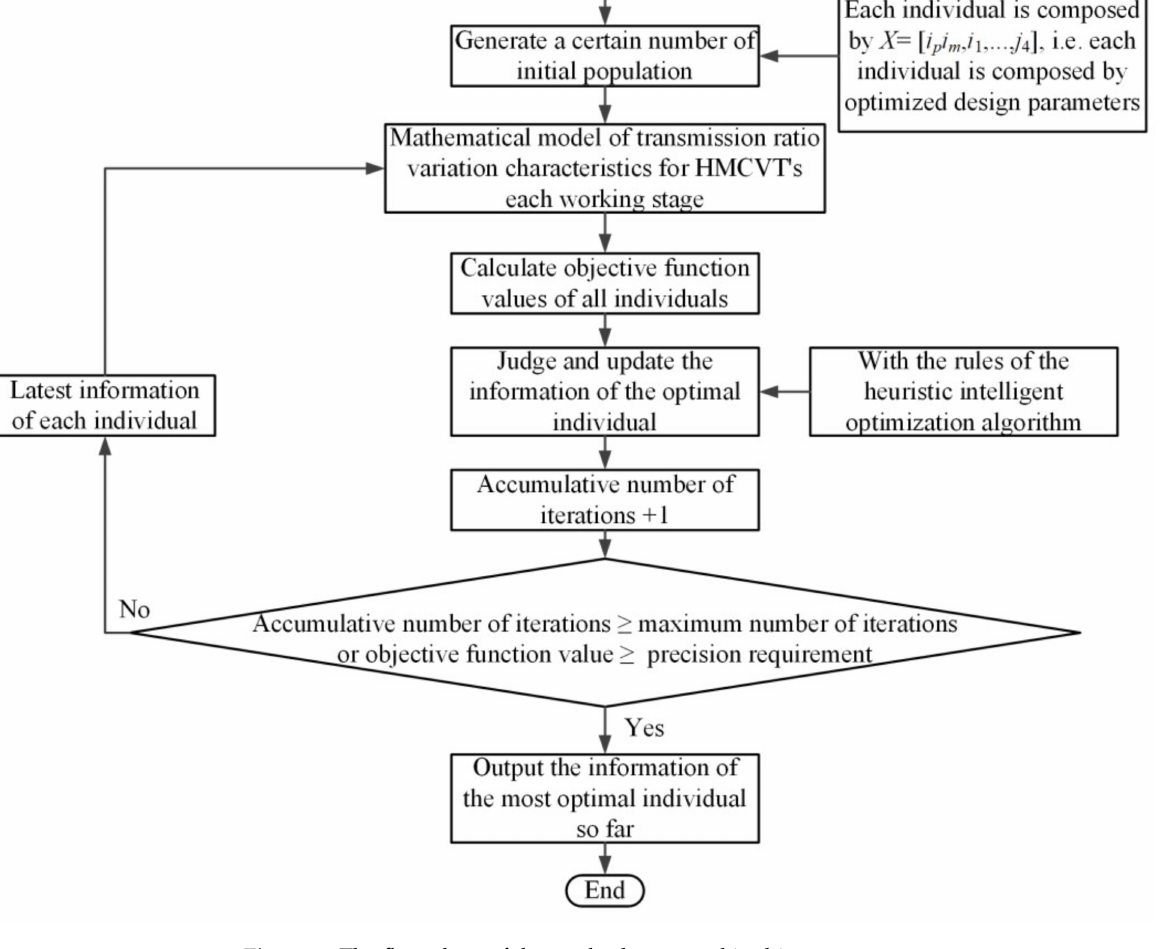
Figure 4. The flow chart of the method proposed in this